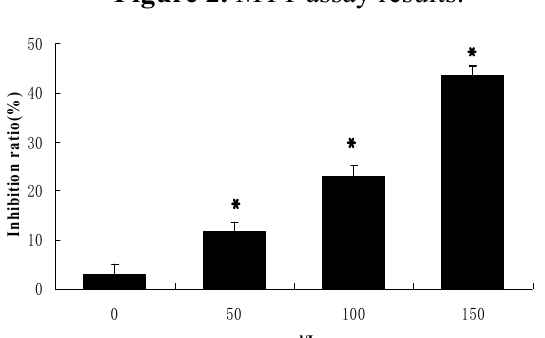
Figure 2. MTT assay results.